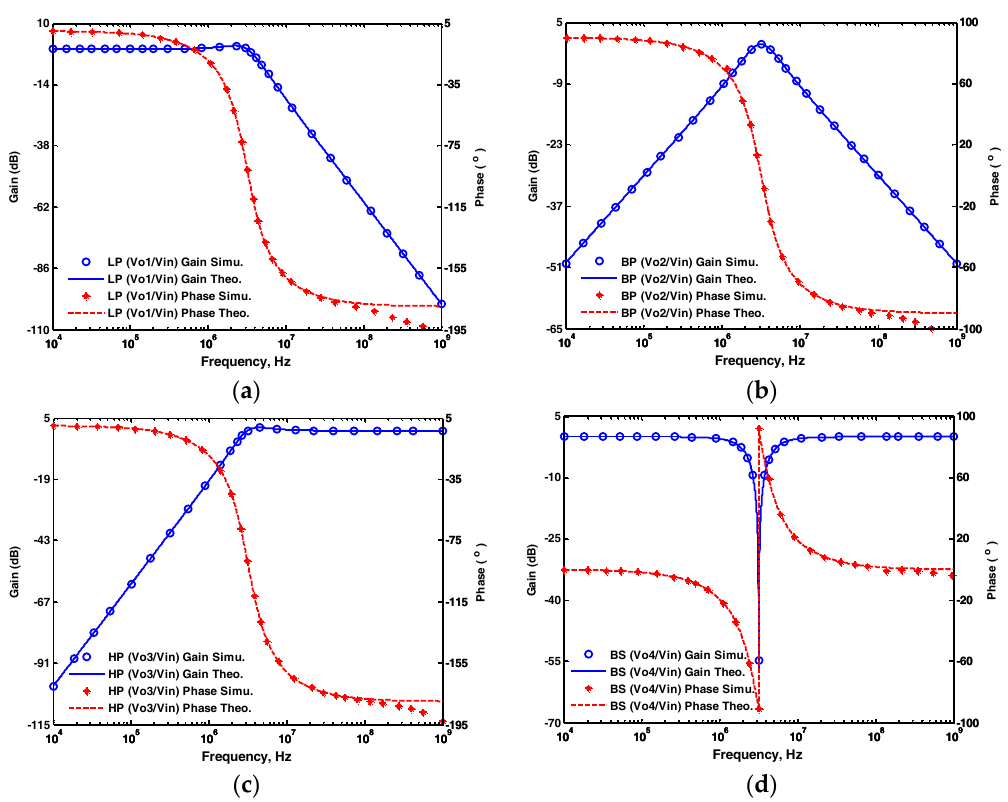
Figure 6. The VM-simulated frequency responses of Figure 2 ( a ) lowpass filter; ( b ) bandpass filter; ( c ) highpass filter; and ( d ) bandstop filter.